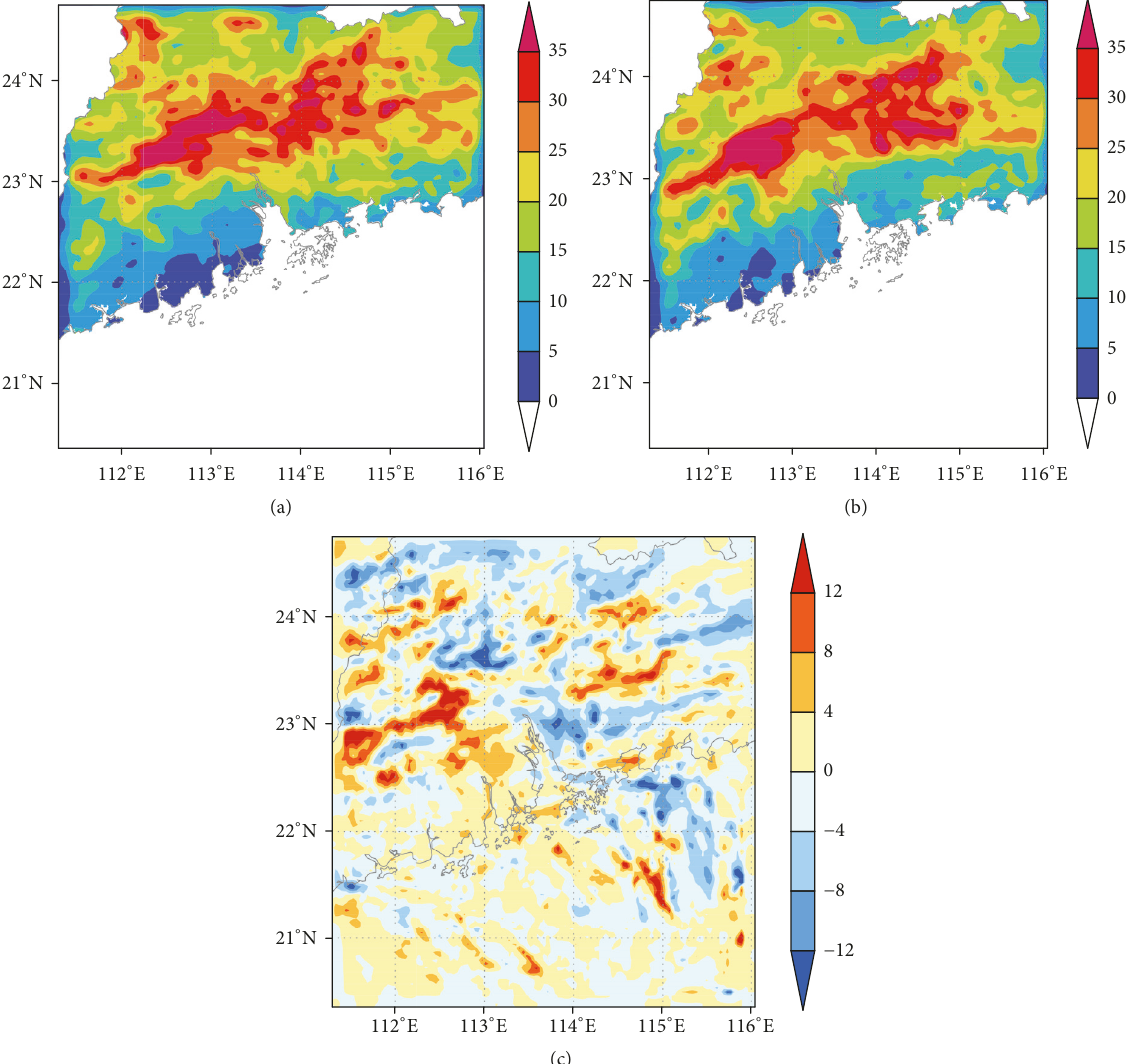
Figure 4: 24-h accumulated precipitation distribution (unit: mm) in PRE-URBAN (a) and URBAN (b) simulations from 0000 (UTC) on 2 January to 0000 (UTC) on 3 January 2010. (c) Differences of 24-h accumulated precipitation (unit: mm) between URBAN and PRE-URBAN simulations (URBAN minus PRE-URBAN) from 0000 (UTC) on 2 January to 0000 (UTC) on 3 January